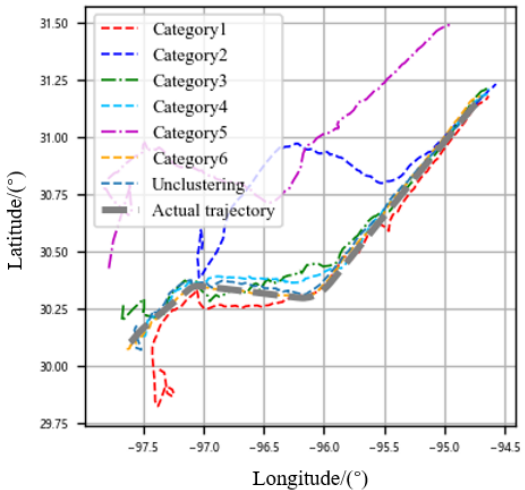
Figure 19. Comparison of the influence of classification training on prediction results.